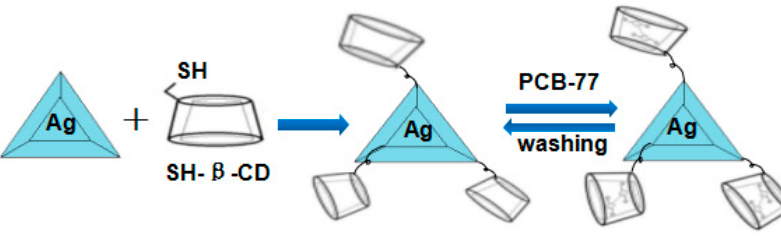
Figure 7. The modification process of SH- β -CDs and PCB-77 on the surface of the nanoparticle array.